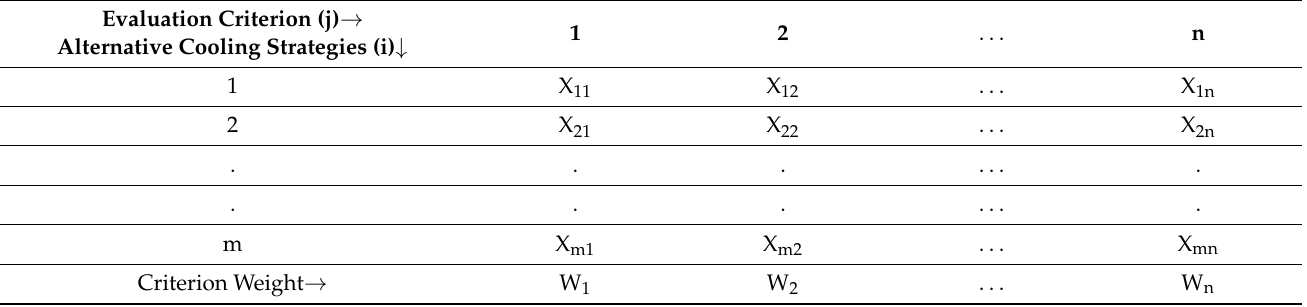
Table 6. Decision matrix for ith cooling strategy and jth criterion.